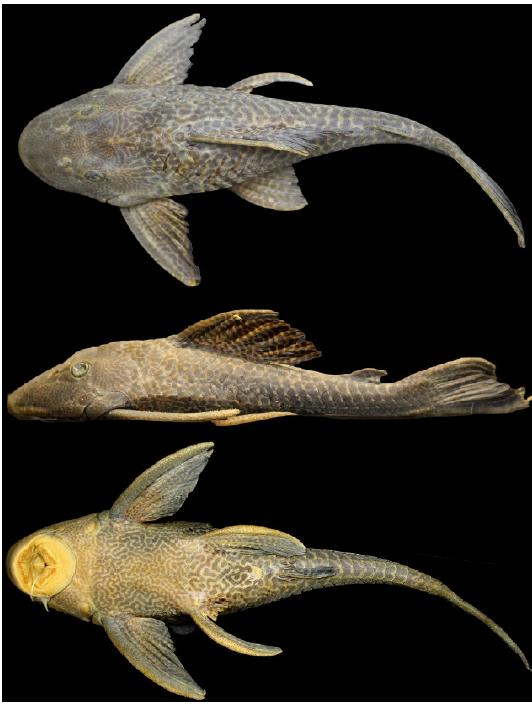
FIGURE 8 | Hypostomus johnii , UFPB 9268, 107.7 mm SL. Poti River, tributary of the Parnaíba River basin, Crateús, Ceará, Brazil.